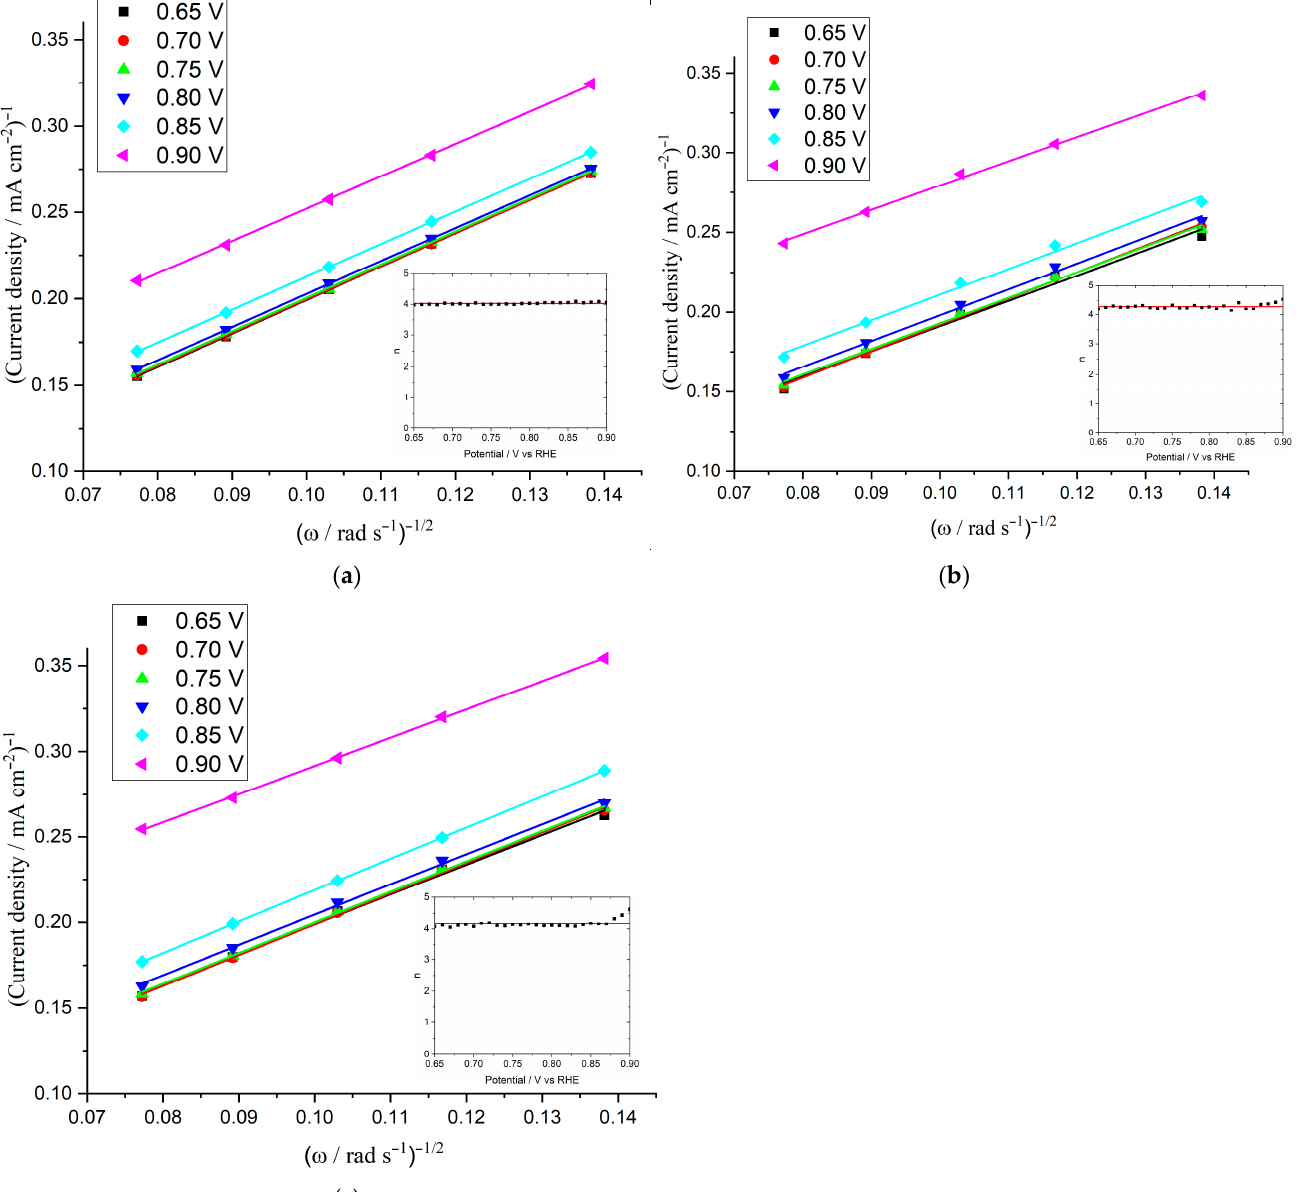
Table 2. Catalyst activity parameters: kinetic current density (j k ), area-specific (S a ) and mass-specific